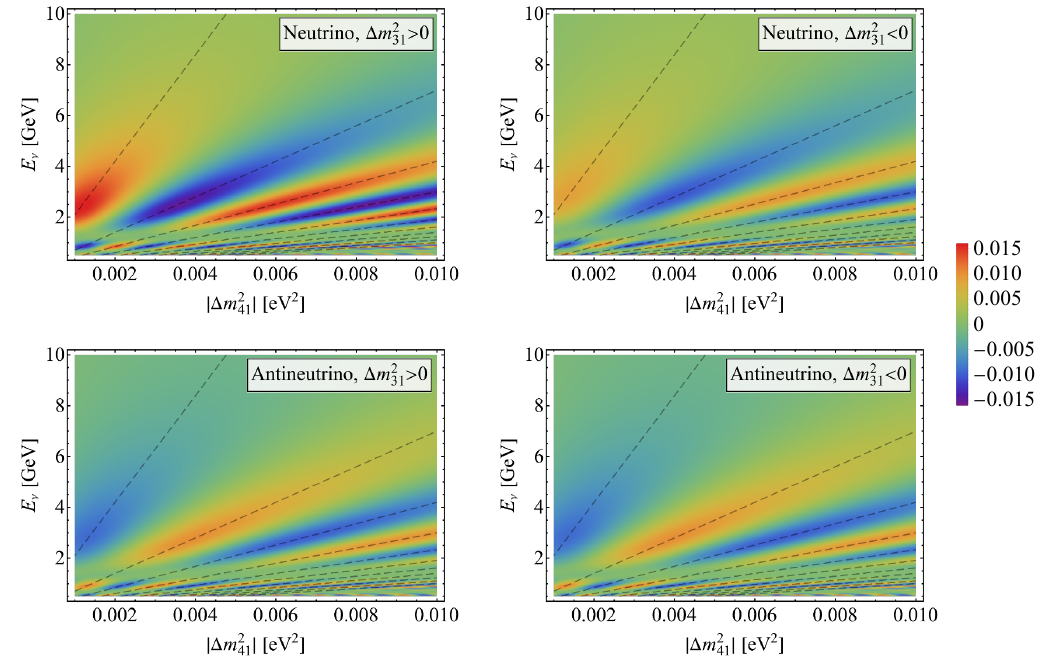
Figure 2 . δP µe [Top panels] and δP ¯ µ ¯ e [Bottom panels] in the (∆ m 2 for the mixing parameters given in eqs. (2.20)–(2.21). Left and Right panels correspond to Normal and Inverted mass ordering, respectively, in the active